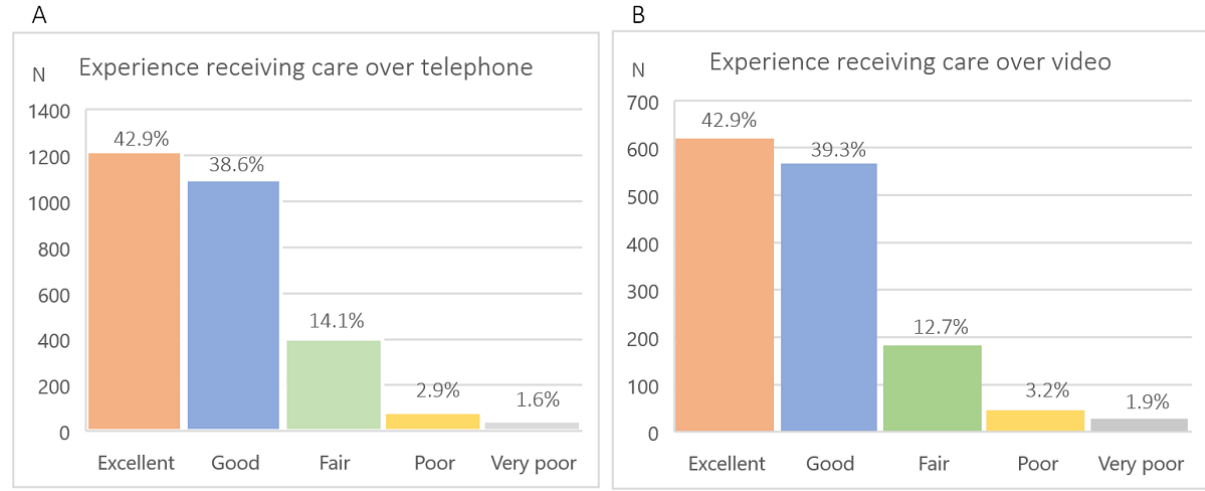
Figure 1. (A) Patients' experience of receiving mental health care via telephone, rated on a 5-point Likert scale ranging from 0=very poor to 5=excellent. (B) Patients' experience of receiving mental health care via video, rated on a 5-point Likert scale ranging from 0=very poor to 5=excellent.